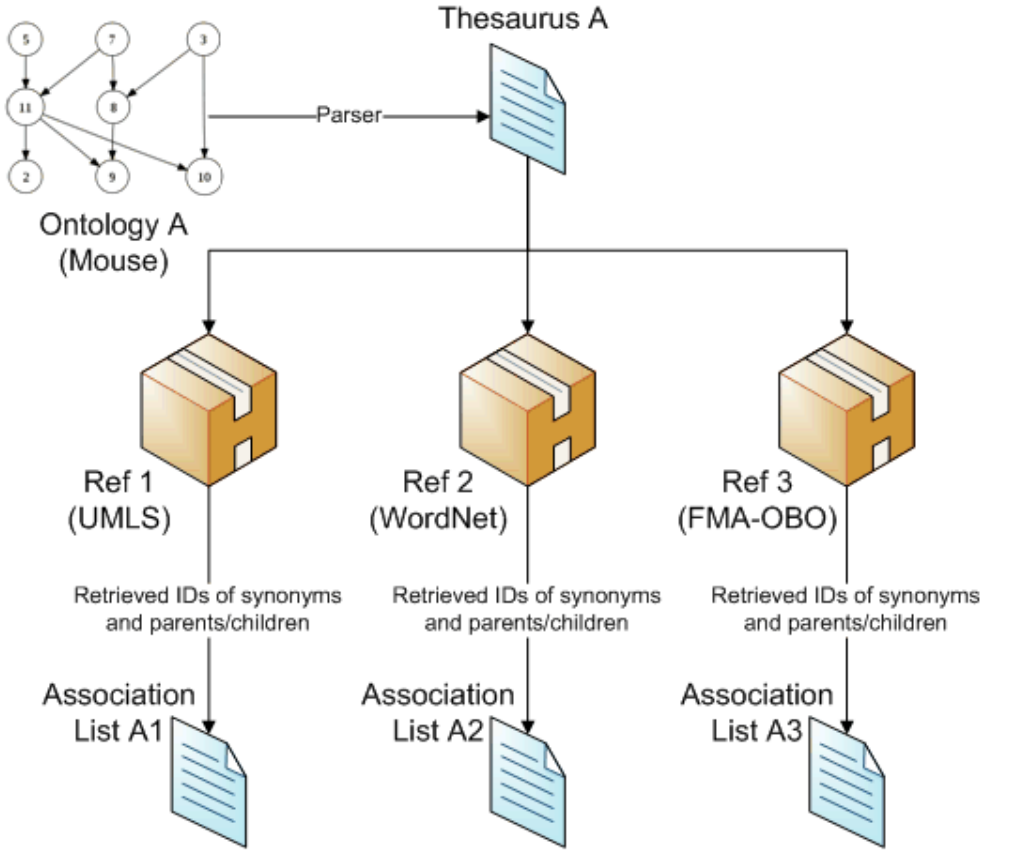
Figure 1a: An ontology is parsed into a thesaurus, which is then submitted to each of the references to produce reference-specific association